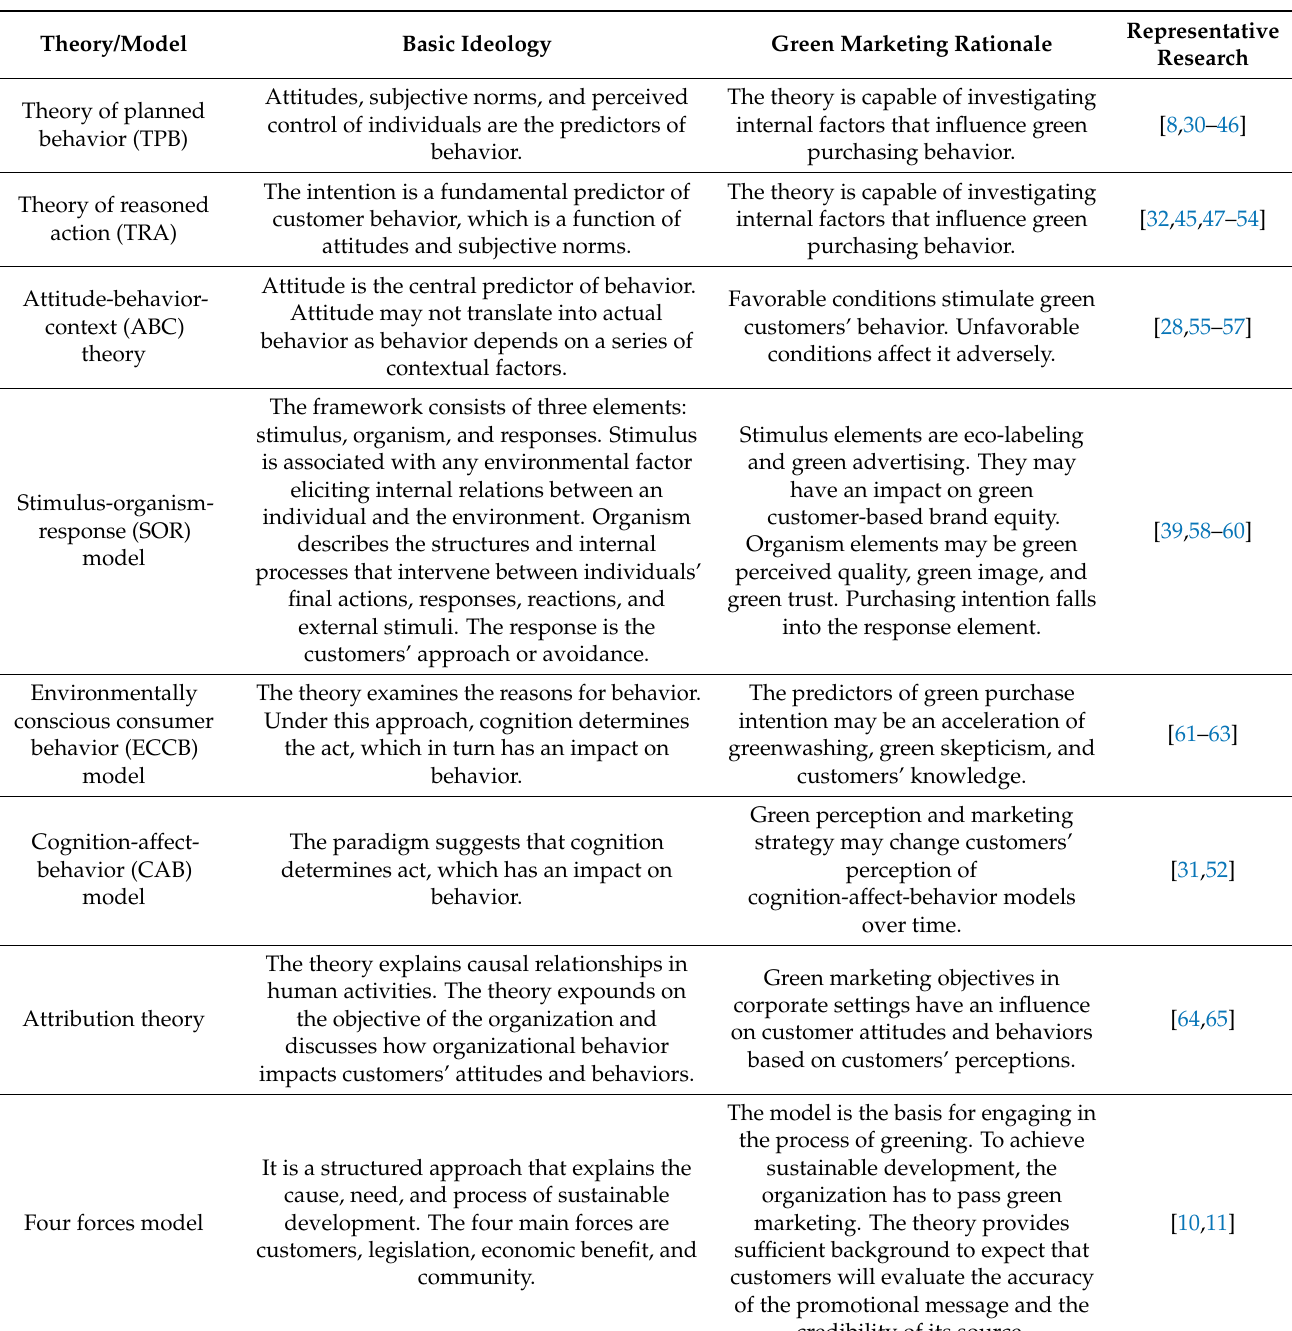
Table 3. Theories/models explaining the impact of green marketing on customer